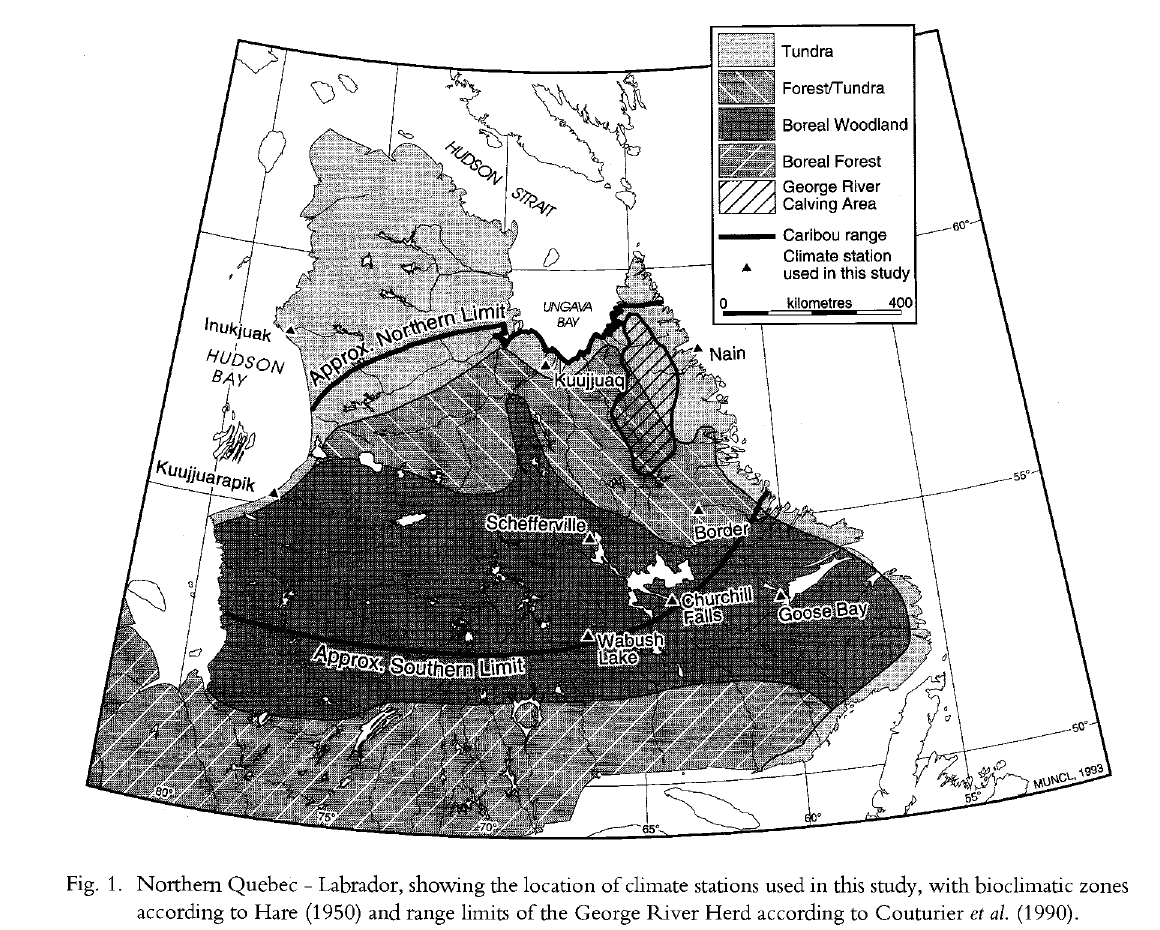
Fig. 1. Northern Quebec - Labrador, showing the location of climate stations used in this study, with bioclimatic zones according to Hare (1950) and range limits of the George River Herd according to Couturier et al.